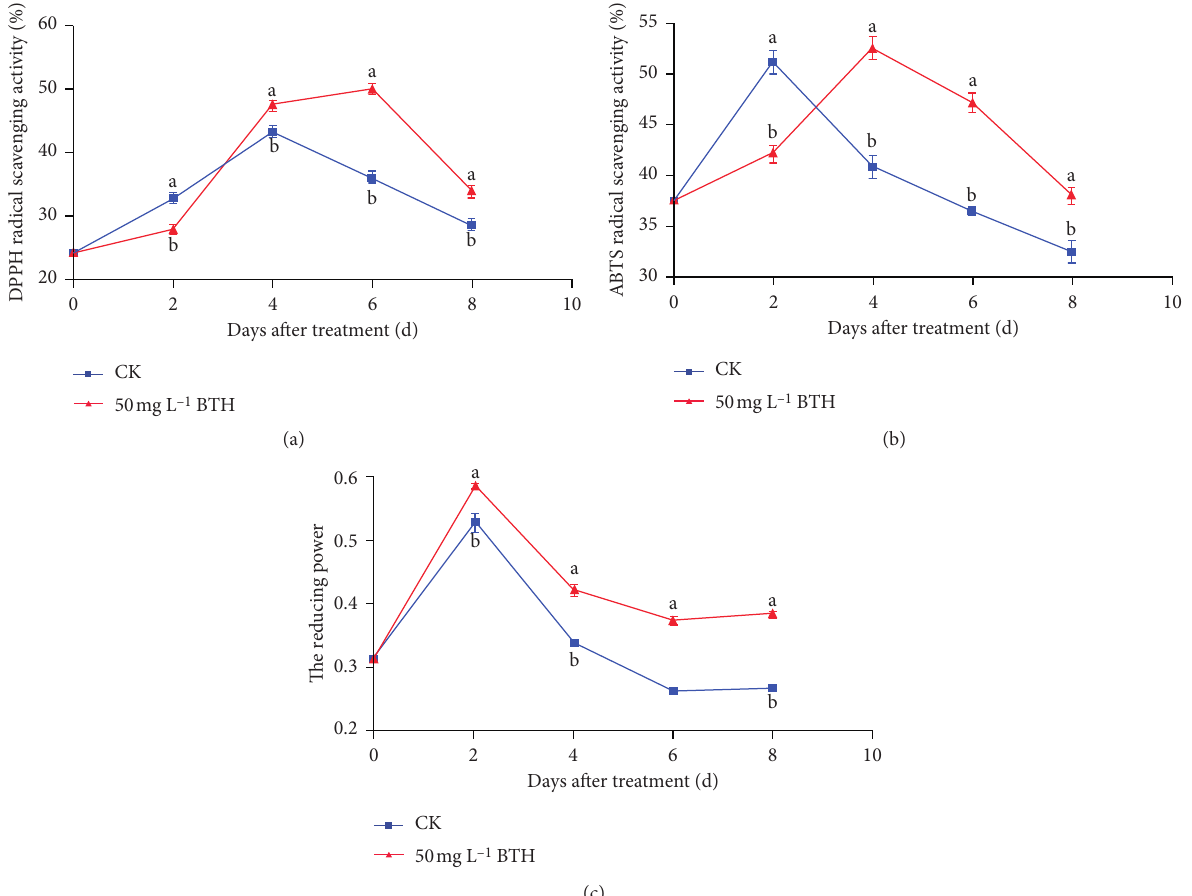
Figure 3: Effects of BTH on antioxidant capacity of navel orange fruits challenged with P. italicum